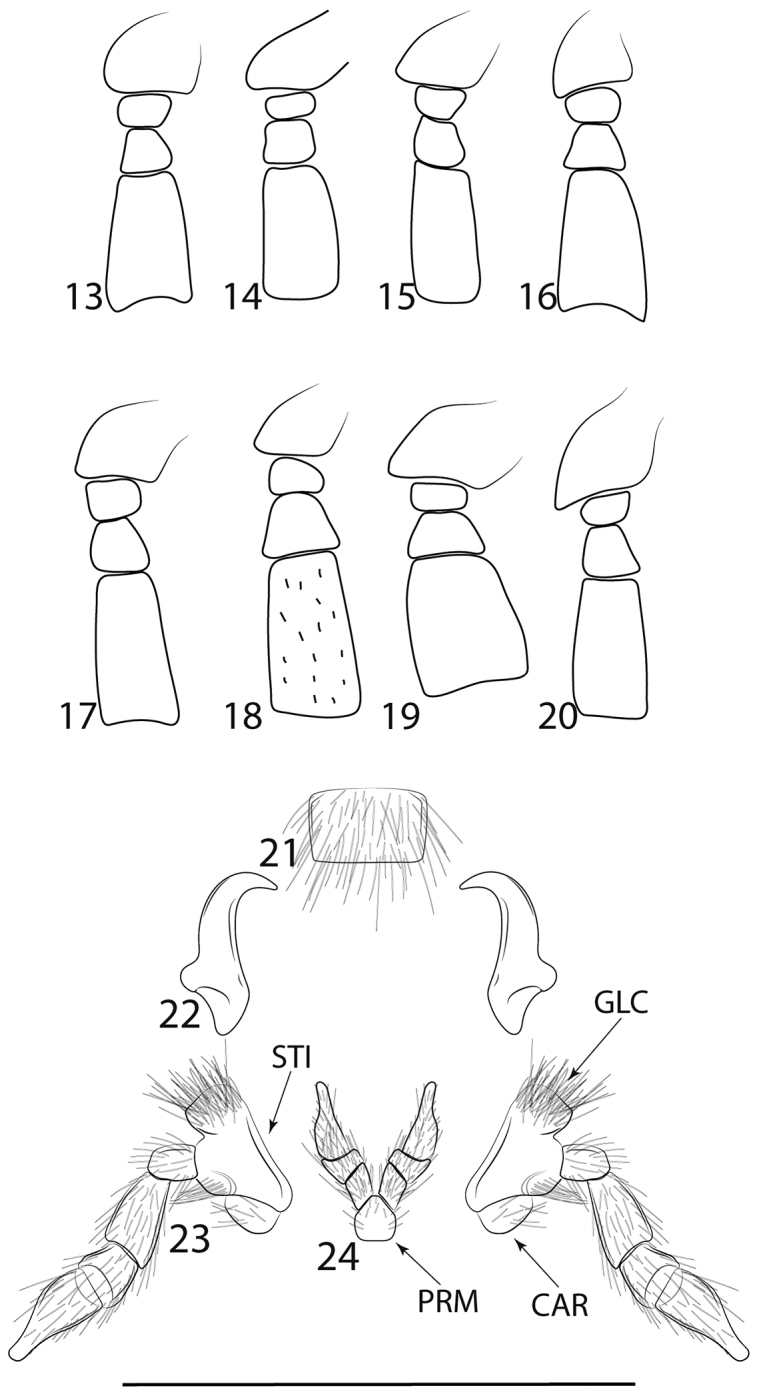
13–20. Antennae, antennomeres I-VI detail. 13L.adamantis14L.hansoni15L.milleri16L.cidaoi17L.marshalli18L.opaca19L.parvula20L.pugliesae21–24Lycinellaopaca mouthparts 21 Labrum 22 Mandibles 23 Maxillary palps 24 Labial palps. Scale bar 0.05 mm. Abbreviations: CAR: Cardo; GLC: Galea+Lacinia; PRM: Prementum; STI: Stipe.